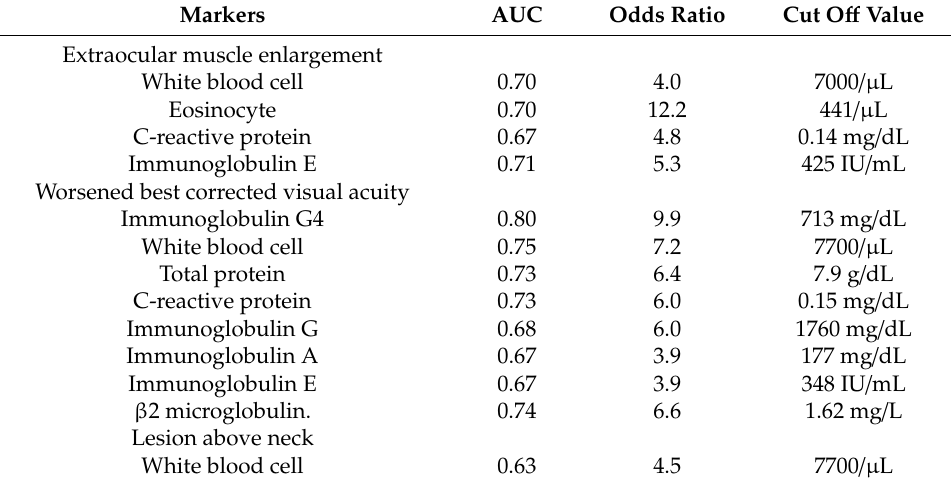
Table 7. Cut-o ff values obtained from receiver operating characteristic (ROC) curve. Markers AUC Odds Ratio Cut O ff Value Extraocular muscle enlargement White blood cell